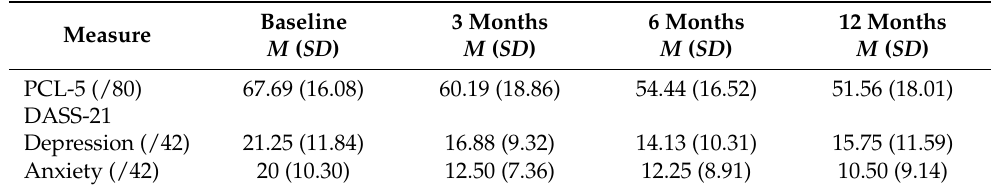
Table 3. Mean and Standard Deviation for Scores on PCL-5 and DASS-21 Depression and Anxiety Subscales.